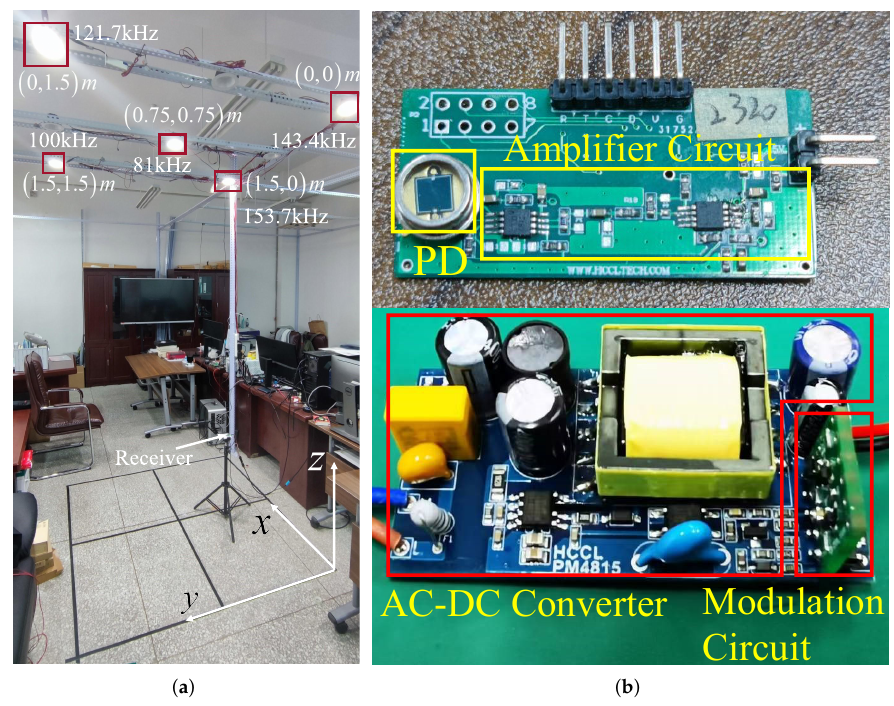
Figure 3. The experimental setup. ( a ) The experimental layout, and ( b ) the hardware